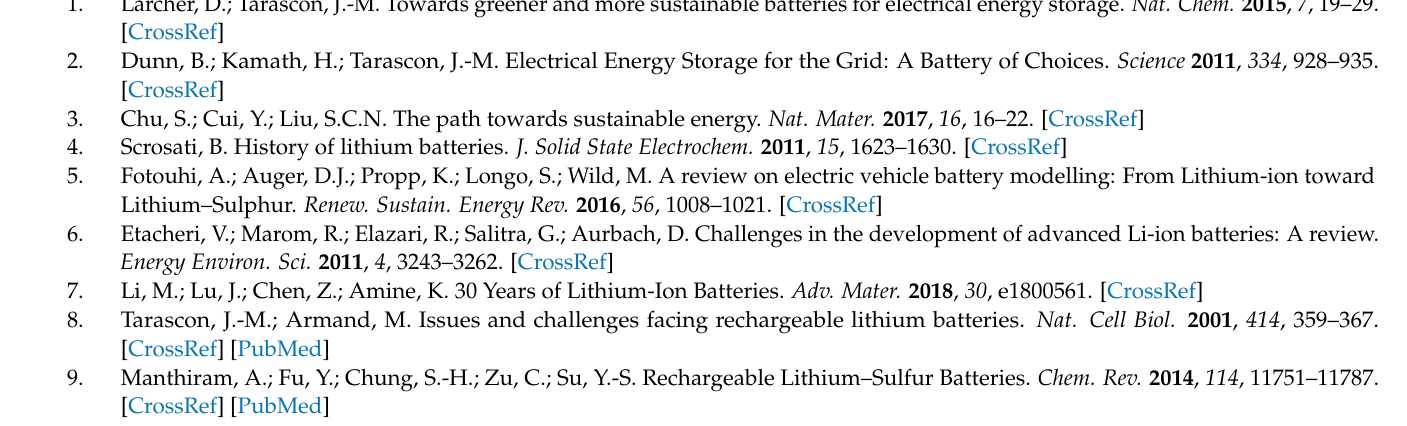
Figure S2: XRD patterns of sulfur graphene nanoplatelets and GNS58, Figure S3: SEM images of graphene nanoplatelets, Figure S4: First and second galvanostatic profiles of GNS58 and GNS58- CNT10 cathode, Figure S5: Galvanostatic rate performance of CNT-containing and reference sulfur hybrid cathodes, Figure S6: Voltage profiles of reference sulfur hybrid electrodes containing carbon particles and graphene